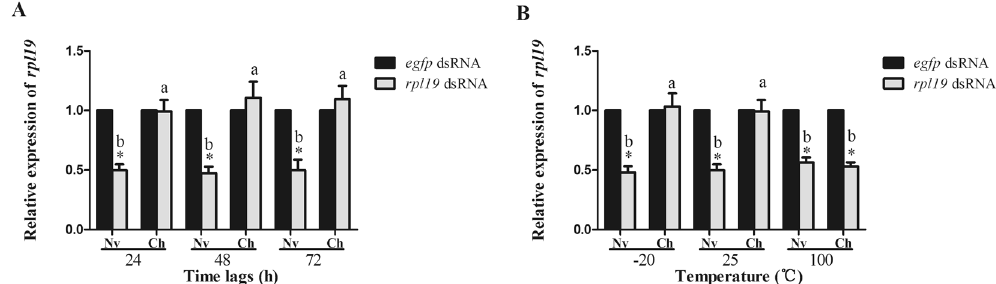
Figure 1. The blockage of RNAi in B. dorsalis can be induced by injecting hemolymph collected from dsRNA- challenged flies. (A) mRNA accumulation of the target gene after feeding ds -rpl19 followed by injection of Ch hemolymph which has been incubated at 25 °C for 24 h, 48 h and 72 h. ( B ) mRNA accumulation of the target gene after feeding ds -rpl19 followed by injecting hemolymph treated at different temperatures. Normalized target gene mRNA accumulation is reported relative to mRNA accumulation of the ds- egfp control, which was set to 1. All error bars represent the S.E. of the mean of three independent biological replicates. * indicates a statistically significant difference in rpl19 mRNA accumulation between the feeding ds- rpl19 group and the control ds- egfp group (P < 0.05, Student’s t-test). Different letters indicate a significant difference in rpl19 mRNA accumulation among the feeding ds- rpl19 treatments (P < 0.05, Duncan’s